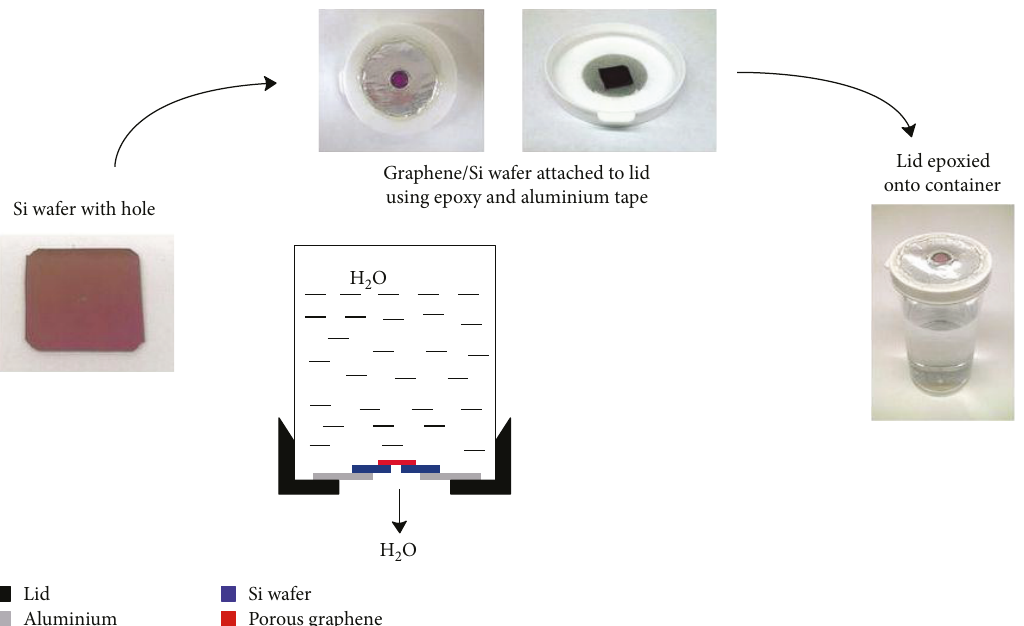
Figure 6: Experimental assembly for water transport measurements and desalination experiments. Reprinted with permission from [44]. Table 1: Overview of the main characteristics of single-layer graphene membranes experimentally investigated for water fi ltration. Membrane Porosity control